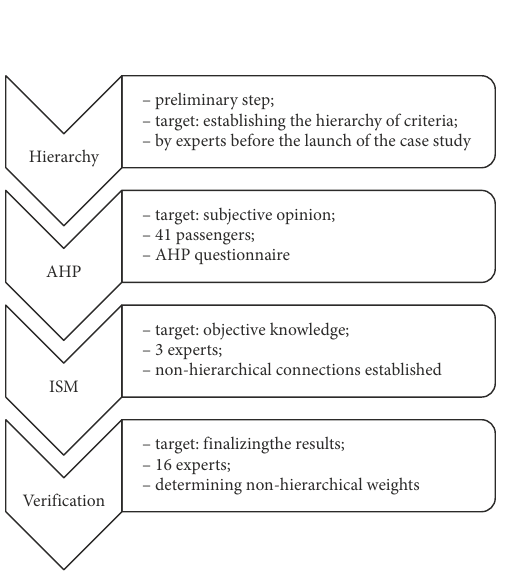
Figure 2. Description of the AHP-ISM